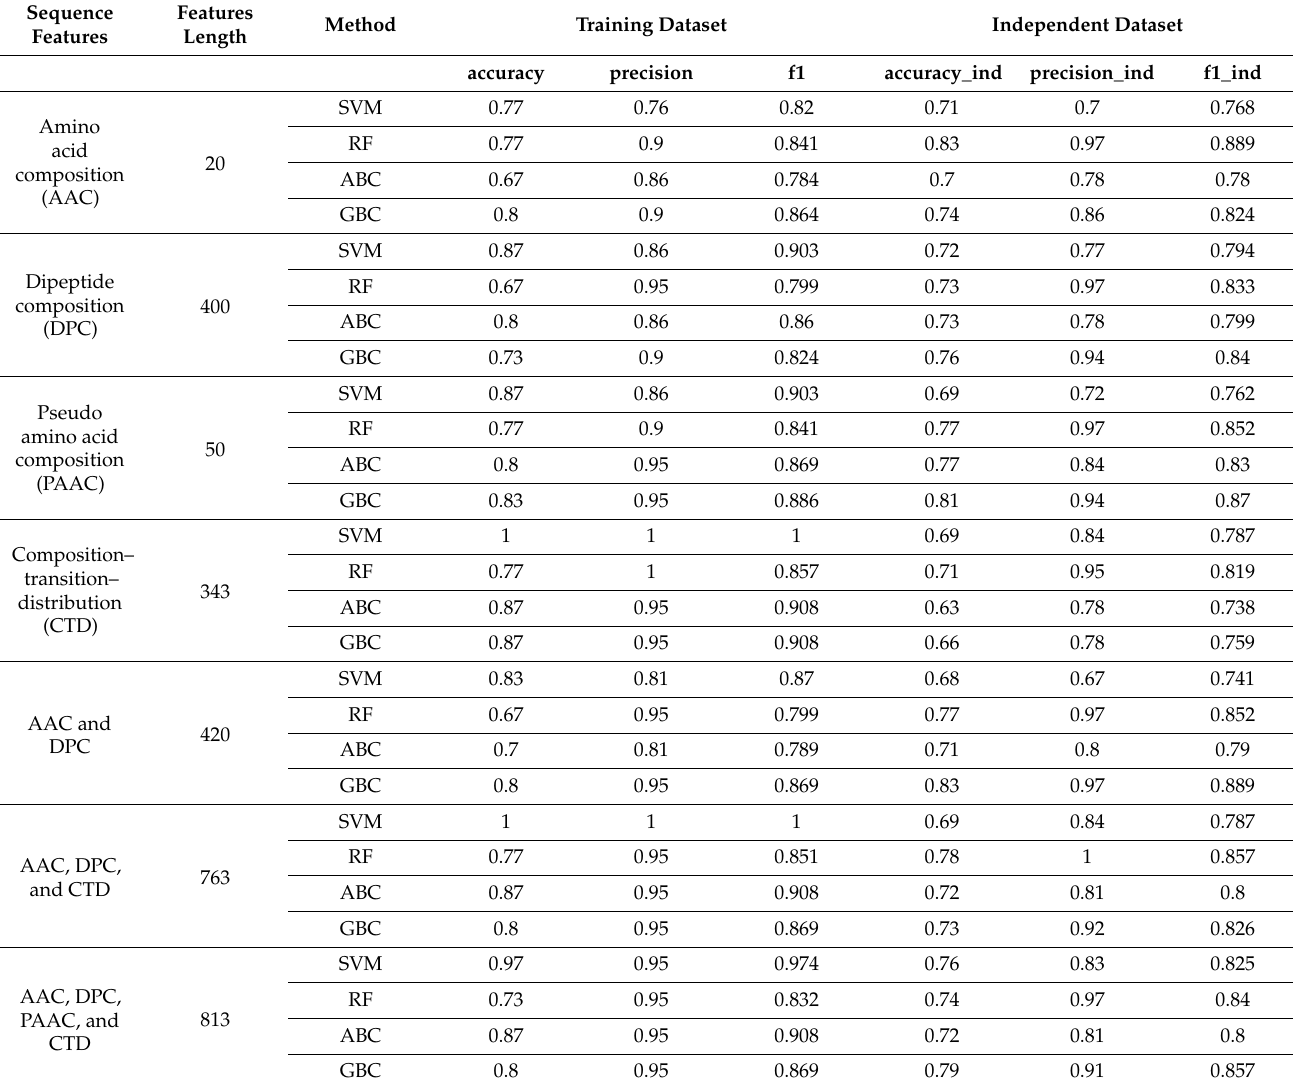
Table 1. Features and methods-wise performance measures on the training and the independent datasets using 10-fold